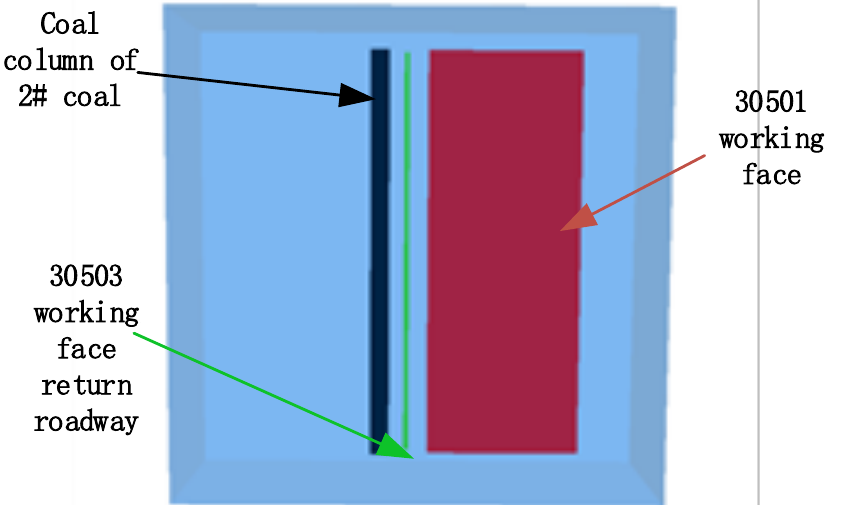
Figure 4. A figure of the numerical model.